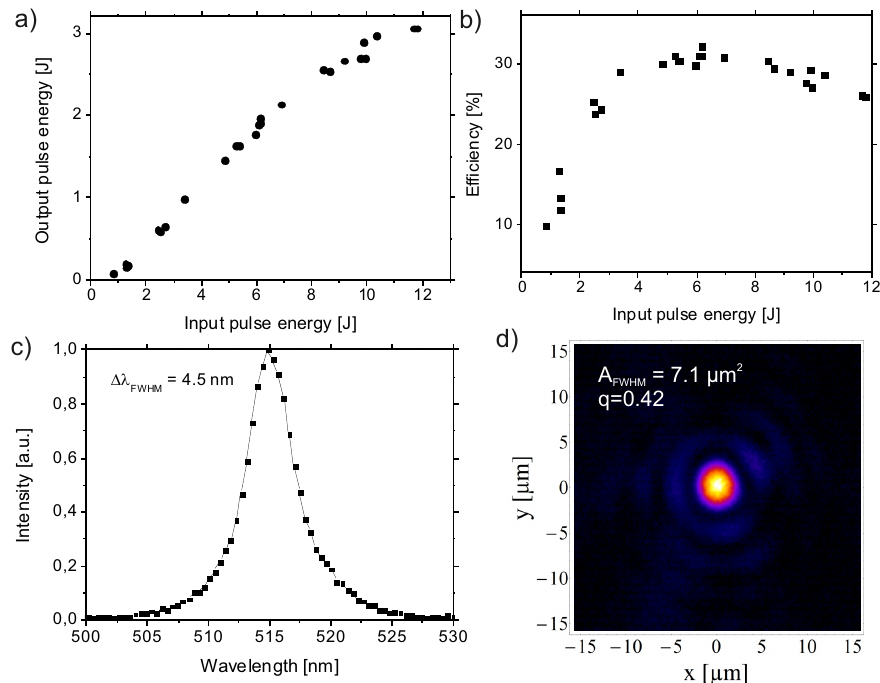
Figure 3. Measurements of the second harmonic generation (SHG) pulses. ( a ) Output (515 nm) versus input (1030 nm) energy; ( b ) Efficiency as a function of input pulse energy; ( c ) Spectral intensity distribution; ( d ) Transverse far-field profile. The area within which